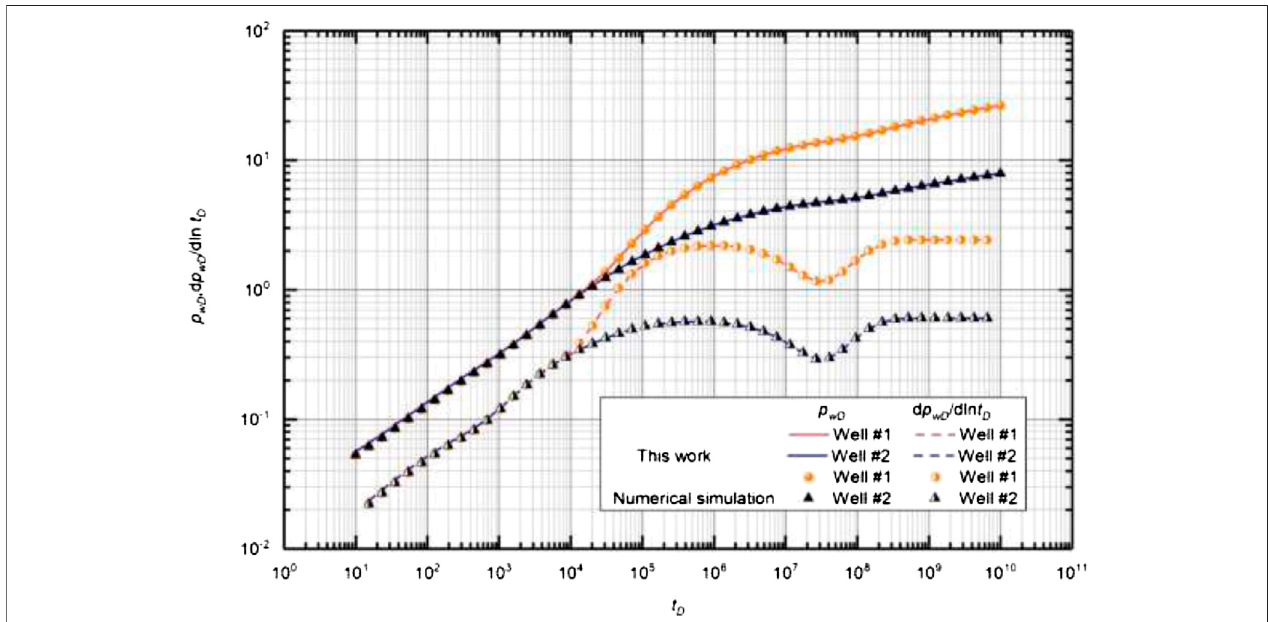
FIGURE 5 | Comparison between the results obtained from this work and numerical simulation from commercial reservoir simulator.